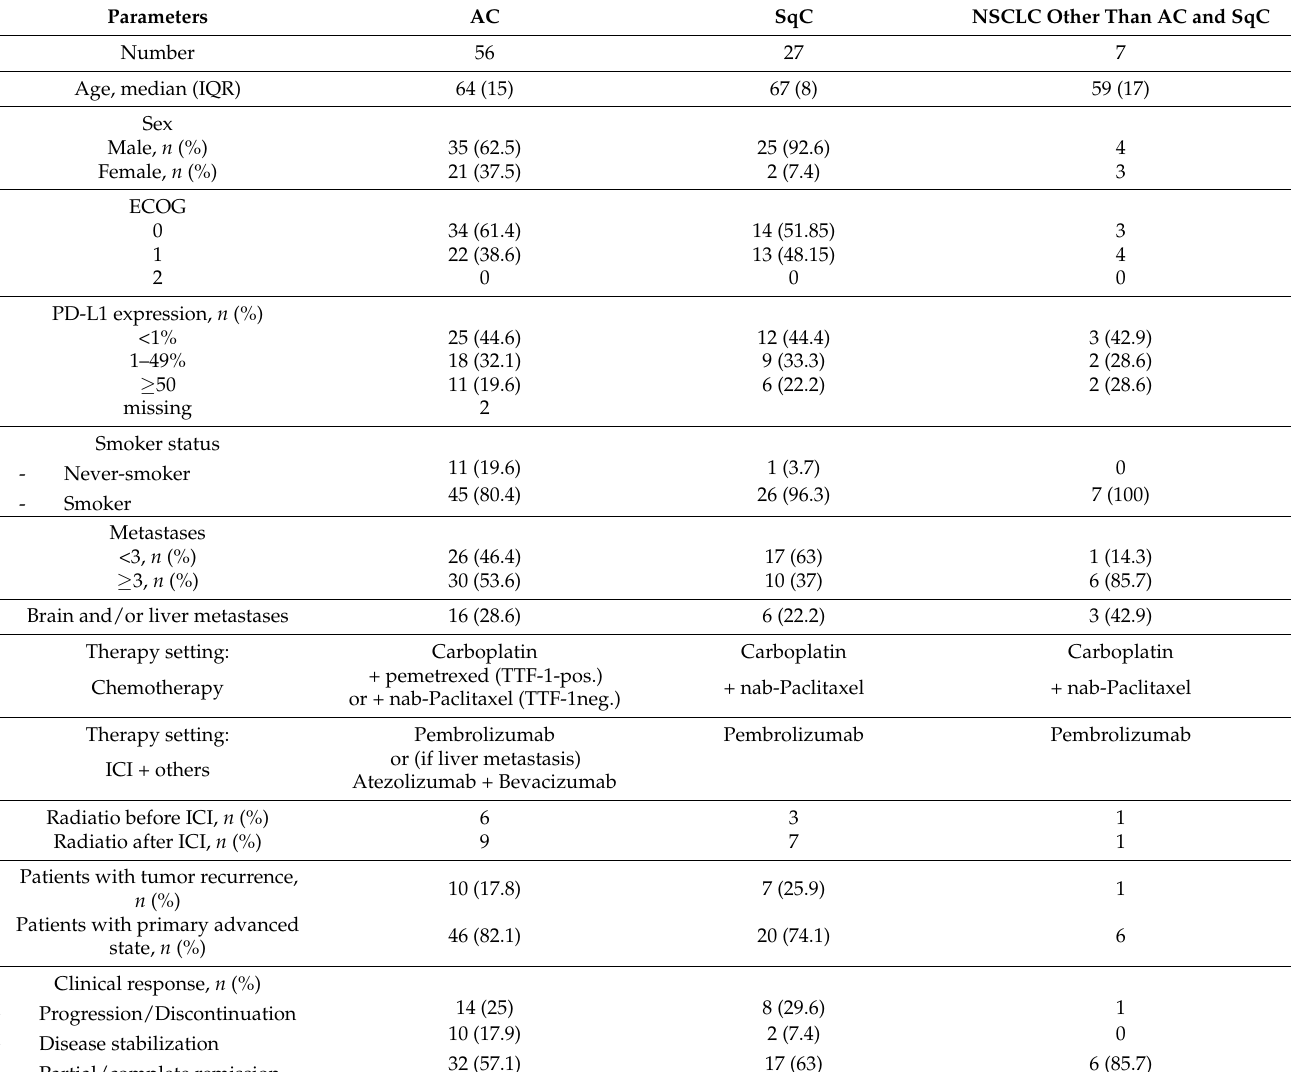
Table 1. Patient characteristics and therapy response of patients. Patients were grouped by cancer histotype to show different therapy